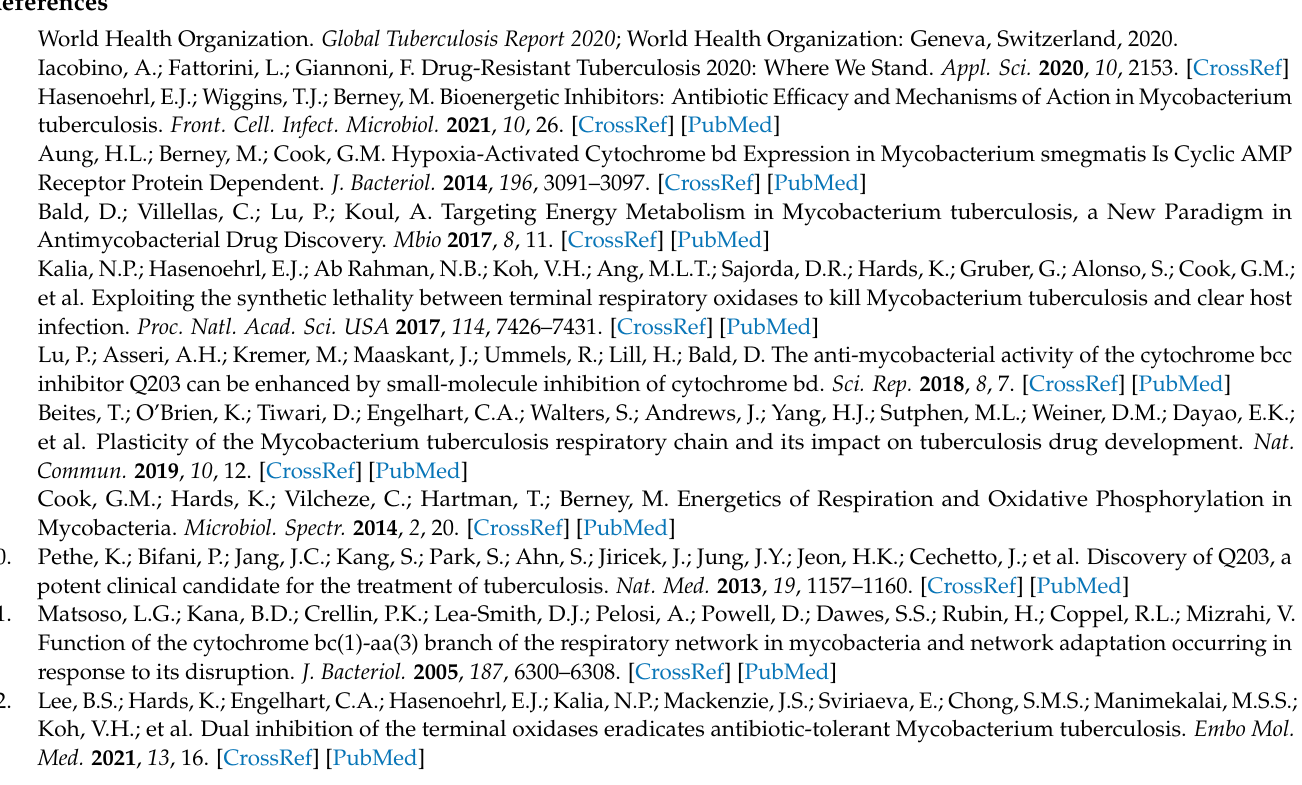
Figure S61: ATP dose response curves of Q203 in M. bovis BCG, M. tuberculosis H37Rv, and M. tuberculosis